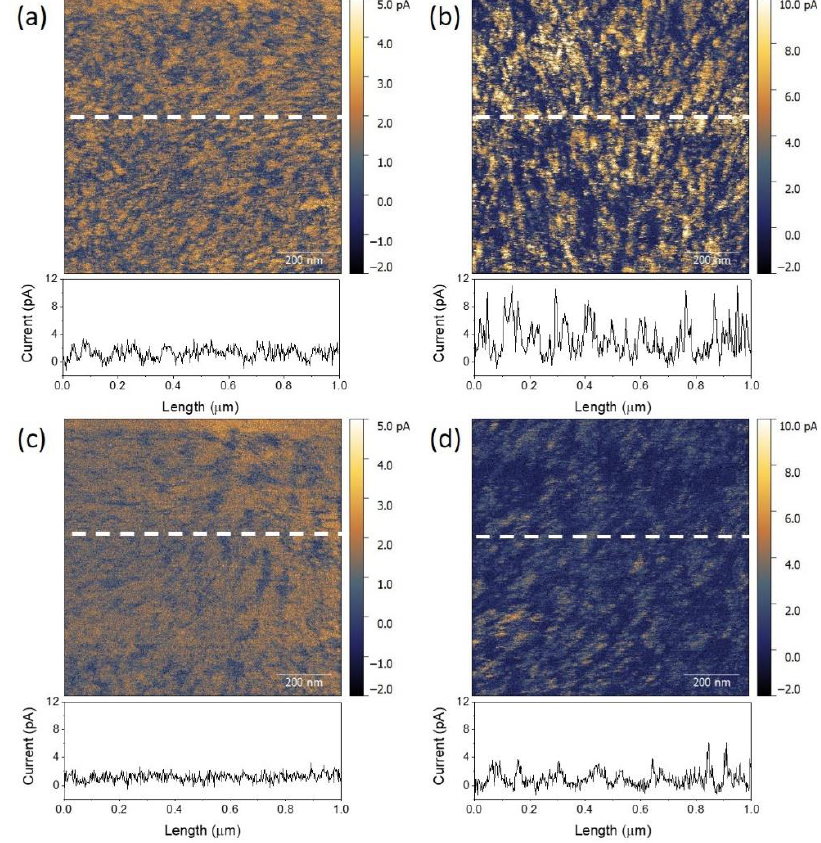
Figure 7. Current maps and their corresponding section profiles (below) of TQ1 / PNDI-T10 = 2 / 1 ( a , c ) and PCE10 / PNDI-T10 = 2 / 1( b , d ) blend films without ( a , b ) and with ( c , d ) thermal annealing.